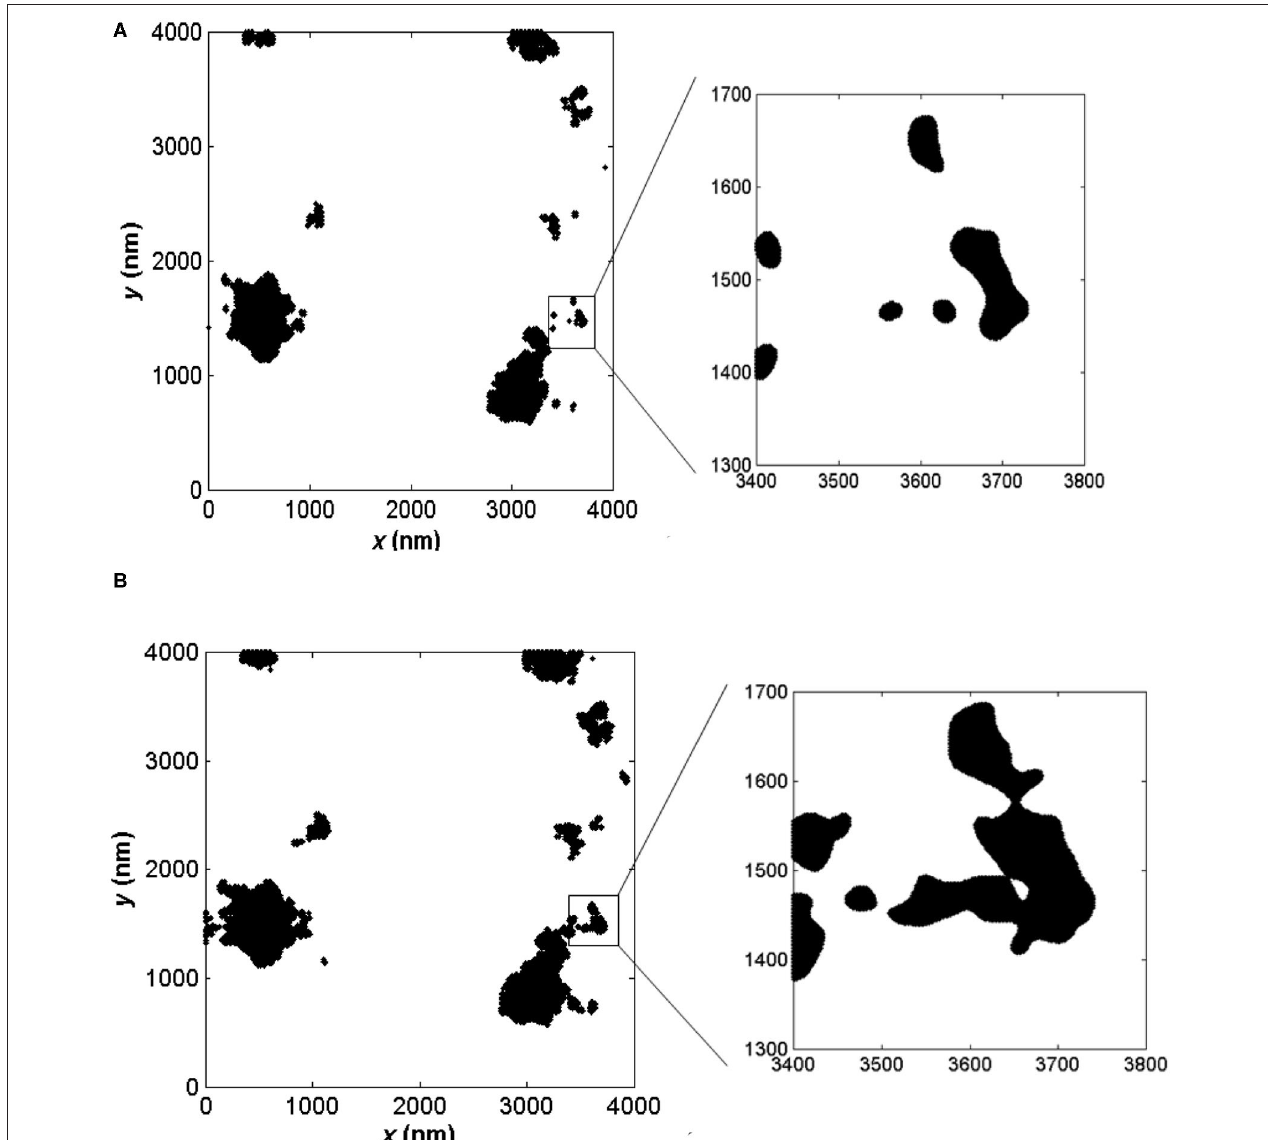
FIGURE 3 | Plane views of a truncated fractal surface. (A) At a given global surface interference, the truncated microcontact areas resemble islands of various sizes. (B) At a larger global surface interference, new microcontacts form and some merge with existing microcontacts to form larger microcontact areas.